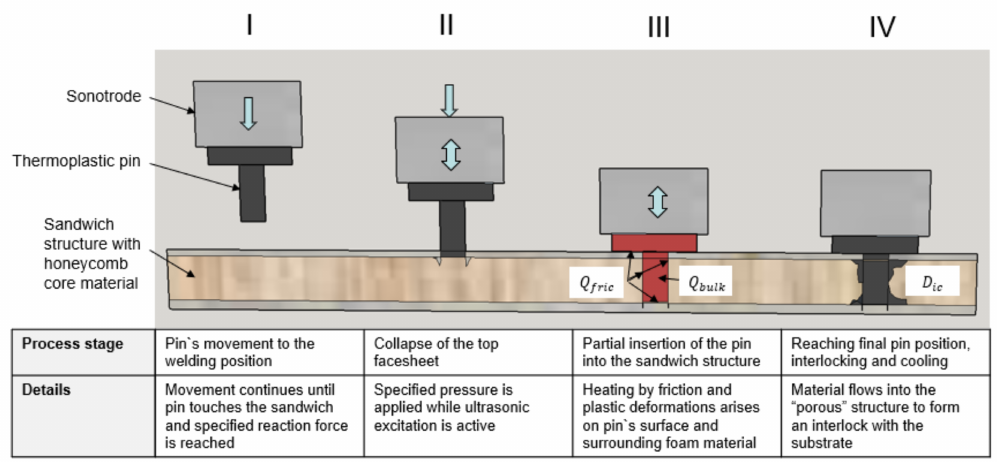
Figure 1. Schematic overview of the MM-Welding ® LiteWWeight ® process. Adapted from Ref.